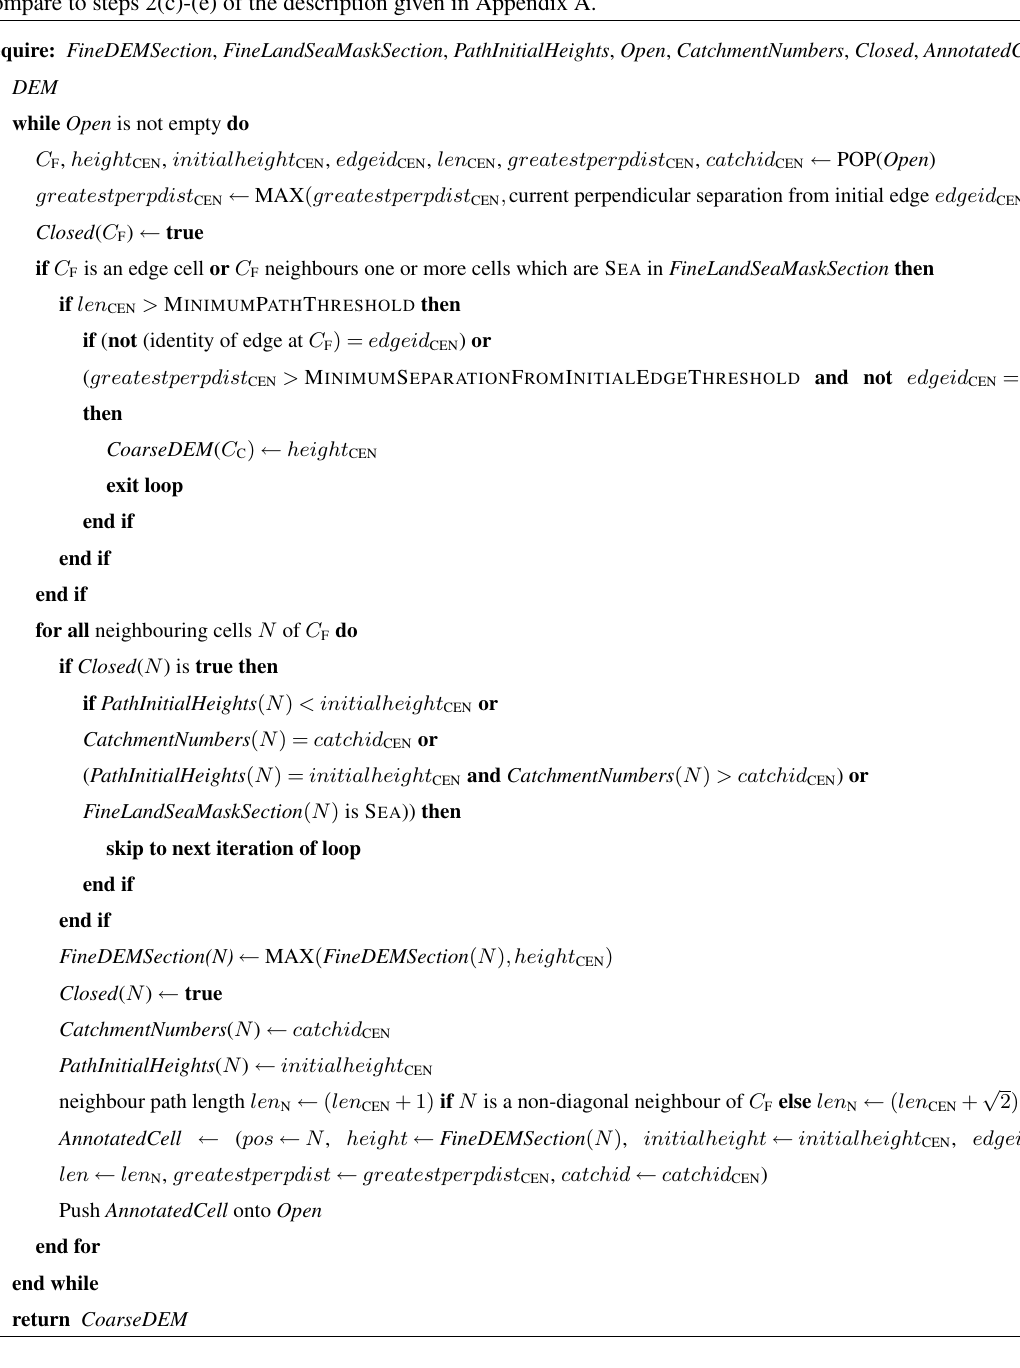
Algorithm 3 Orography upscaling algorithm process